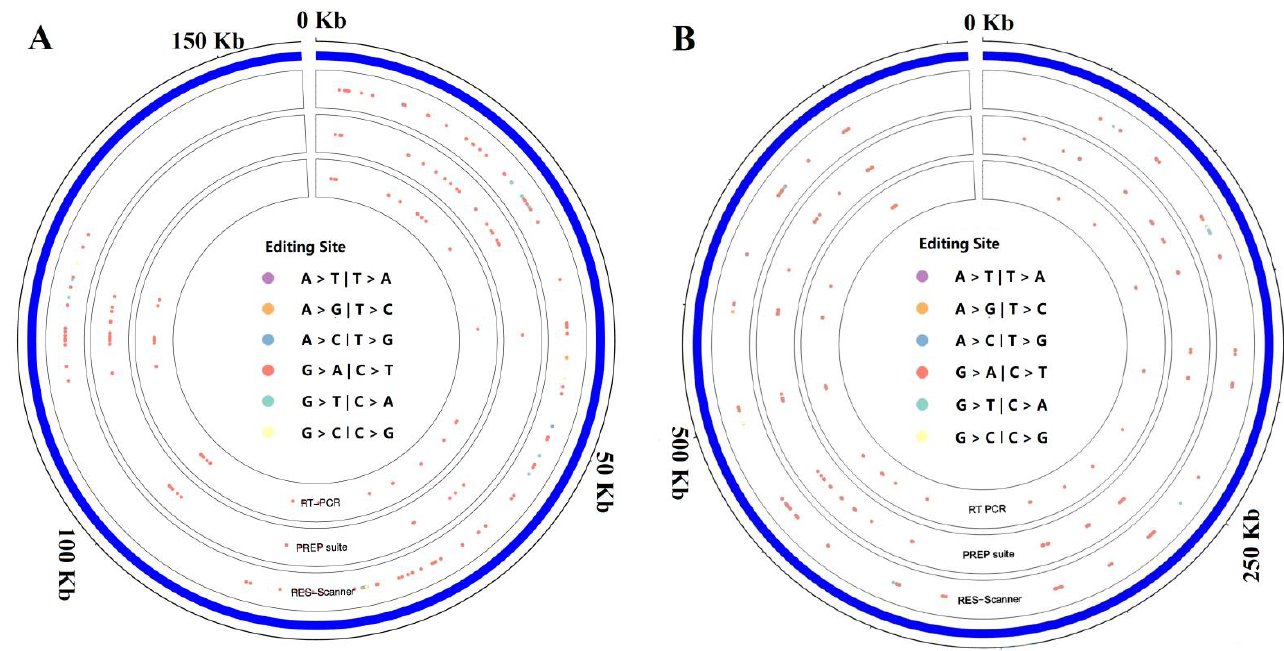
Figure 2. Distribution of RNA editing sites on the tea chloroplast ( A ) and mitochondria ( B ) genome. PREP suite and RES-Scanner represent the results predicted by PREP-suite and RES-Scanner, respectively. RT-PCR represents these RNA editing sites that were validated by RT-PCR. For mitochondria, 65.58% (221/337) of the RNA editing sites were at the second base, while the remaining 34.42% (116/337) were at the first base (Figure 1B). Of the sites, 80 resulted in S > L transitions, followed by P > L (n = 77), S > F (n = 45), R > C (n =